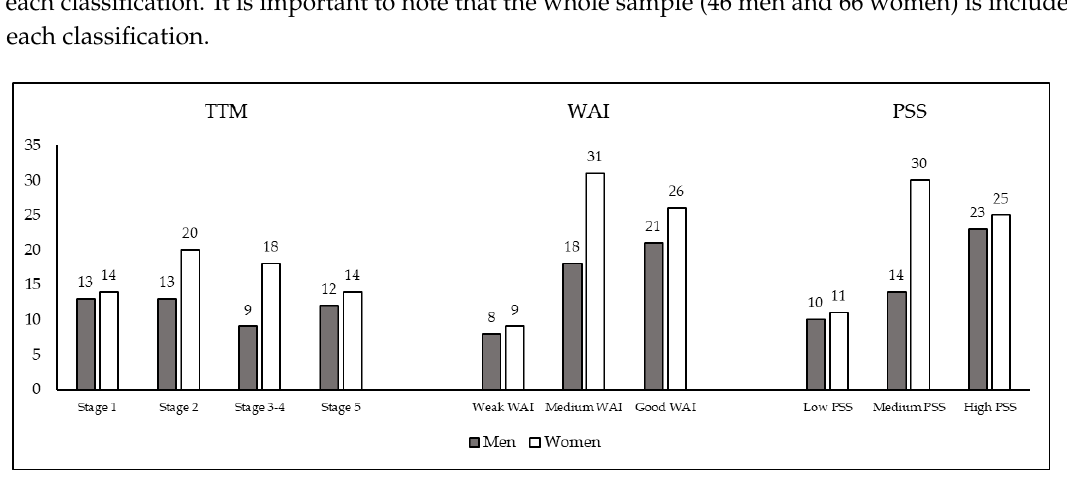
Figure 2. The number of participants in each classification. Abbreviations: TTM, Transtheoretical Model; WAI, Work Ability Index; PSS, Perceived Stress